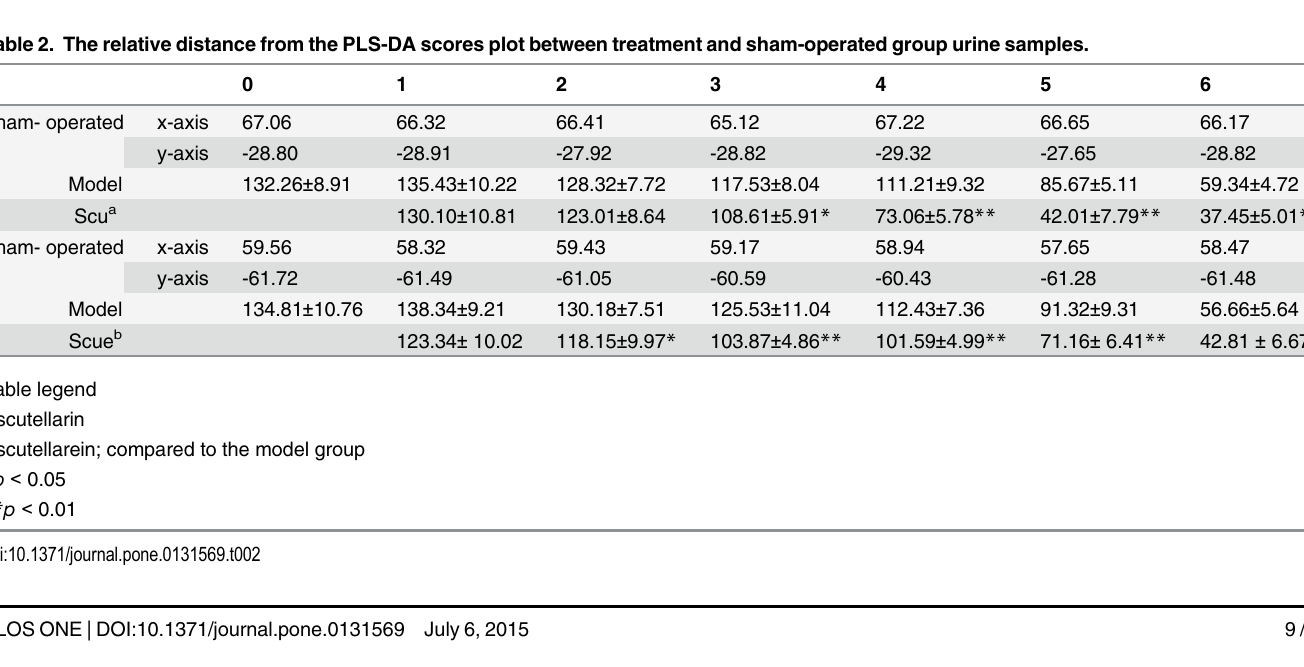
Table 2. The relative distance from the PLS-DA scores plot between treatment and sham-operated group urine samples.